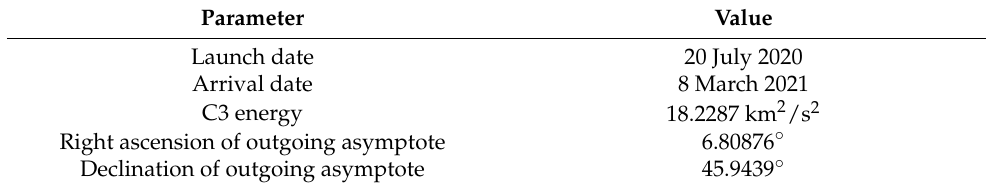
Table 1. Initial orbital parameters.